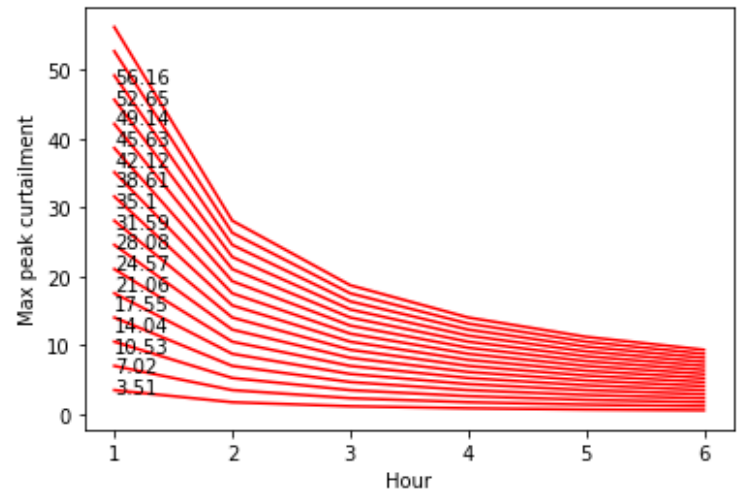
Figure 7. Level of peak curtailment the battery sizes referenced in Figure 6 can sustain over extended periods.